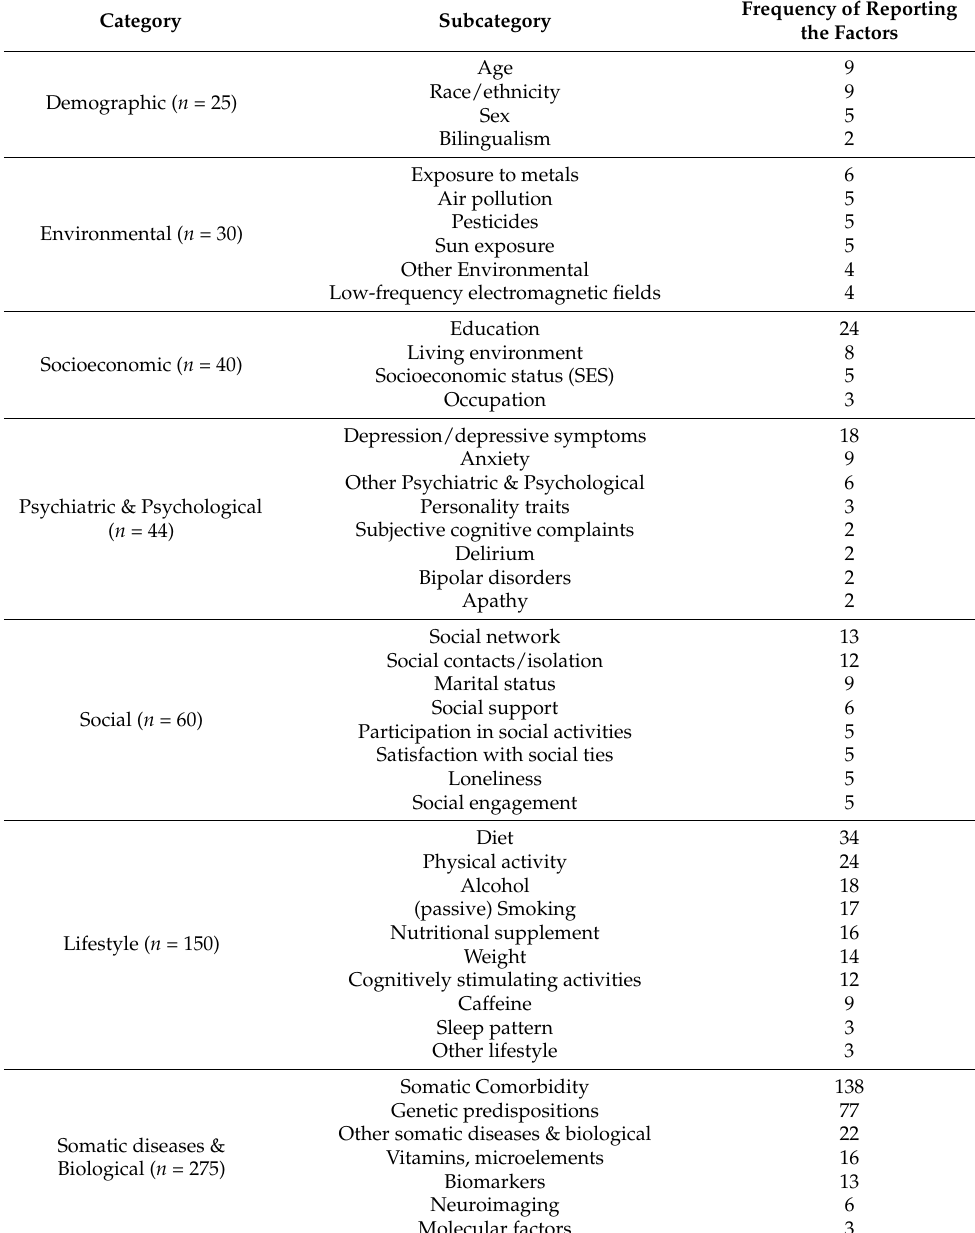
Table 2. Final categories with the number of reported factors for each